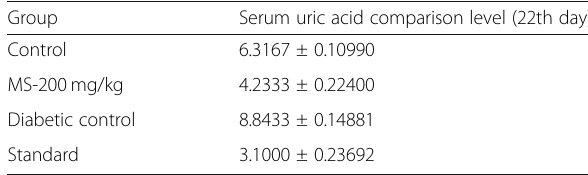
induced diabetic nephropathy